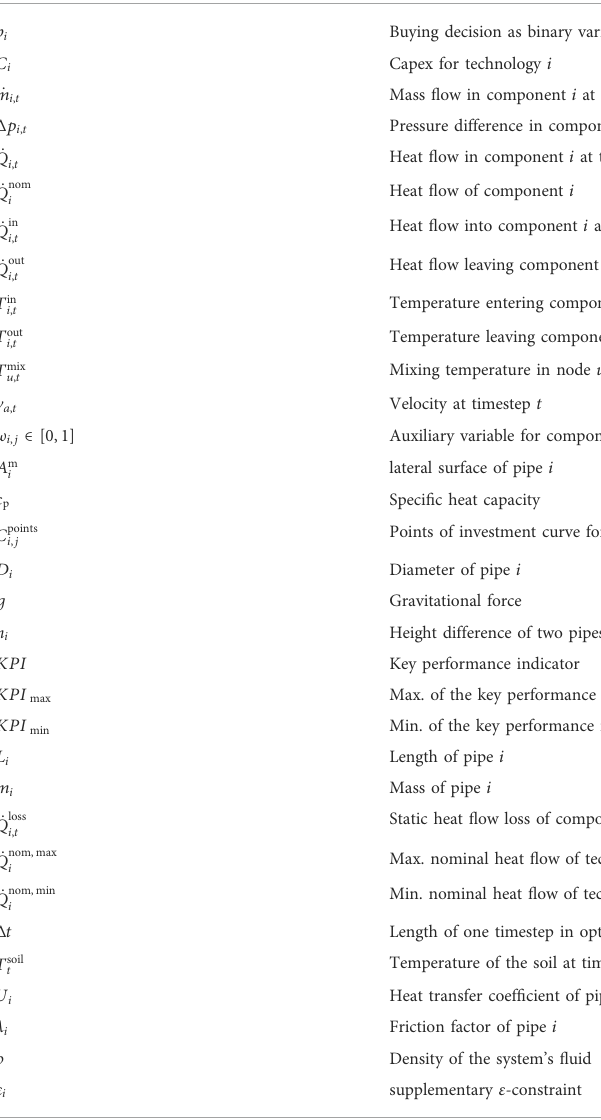
TABLE 2 Declarations of symbols with variables in the top and parameters in the bottom.